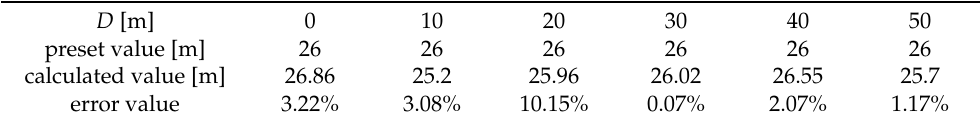
Table 2. Localization results in the z -direction for different distance